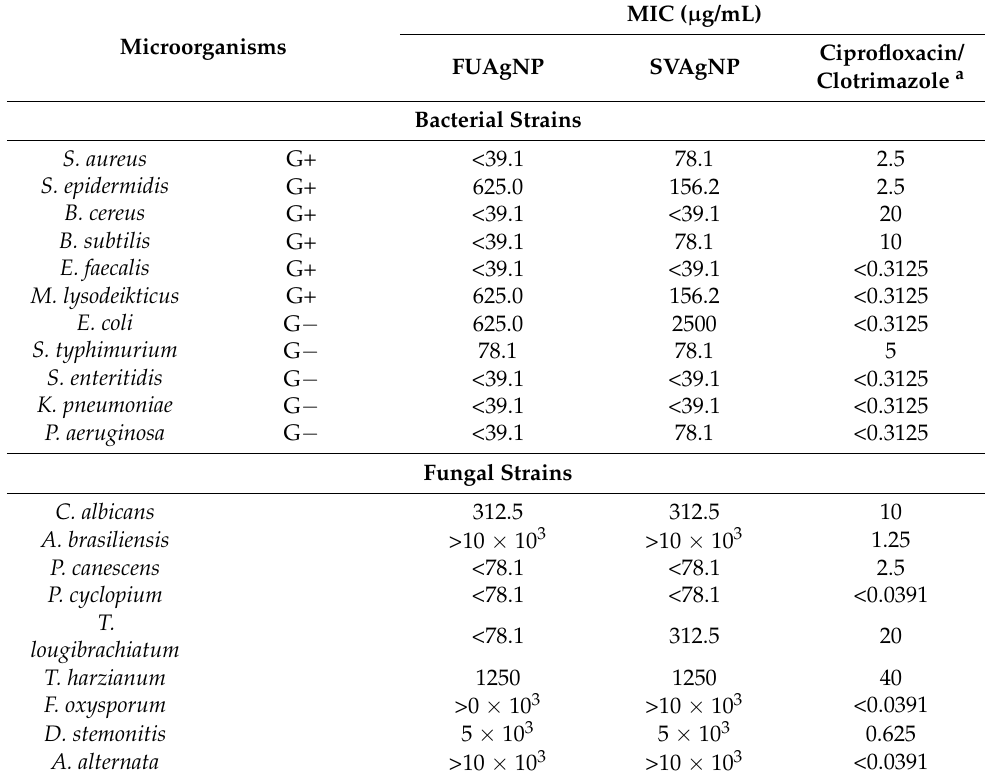
Table 1. Antimicrobial activity of synthesized